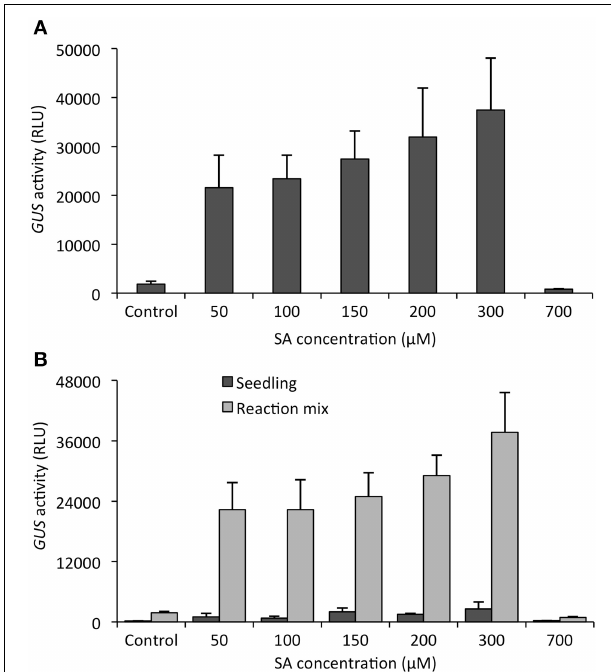
FIGURE 6 | The reaction product of the in situ GUS assay accumulates in the medium. Arabidopsis seedlings harboring the SA-responsive PR1p::GUS reporter gene, grown for 12 days in liquid culture, were treated with increasing concentrations of SA (or 0.2% DMSO as control) for 24h. (A) GUS activity of whole seedlings ( in situ ) was quantified as before (see Materials and Methods). (B) Following 4-MU quantification, seedlings were removed from first assay mixture, transferred to new microplates and 4-MU fluorescence emitted from seedlings only (black bars) or the reaction mixture devoid of seedlings (gray bars) quantified. The reaction product, 4-MU, is almost exclusively localized in the medium. All values represent the mean ( ± SD) of four biological